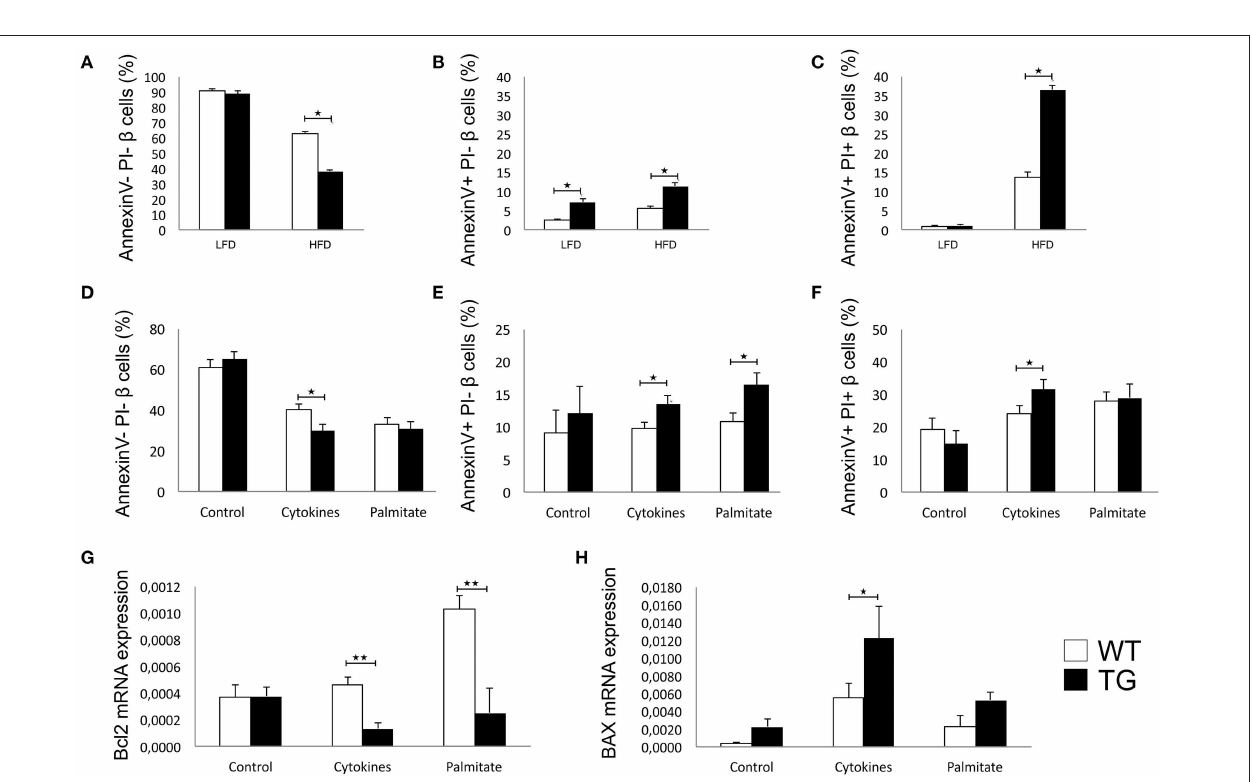
FIGURE 3 | TG mice on HFD compared to WT mice (D) . Percentage of β cells, TLR4 + and galectin 3-positive β cells in islets. Analysis of the islet cells did not show a significant difference in the total number of β cells in islets in the two experimental groups on HFD. However, there was a significantly higher percentage of Glut-2-positive cells expressing TLR4 and galectin 3 in the TG mouse group (E–G) . Percentages of F4/80 + , F4/80 + TLR4 + , and F4/80 + Galectin3 + cells in islets. Representative contour plots for F4/80 + TLR4 + cells in islets. The percentage of F4/80 + macrophages, as well as the percentage of galectin 3-positive and TLR4-positive macrophages, was significantly higher in the islets of TG mice (H–J) . An analysis was performed by light microscope using a 40X magnifying lens. Results are presented as a mean count of positive cells per field or percentage of islet area on 10 non-overlapping fields/section. Data from two experiments with 10–15 mice per group are shown as mean ± SEM; by Mann-Whitney U -test and independent-sample Student’s t -test; * p < 0.05, ** p < 0.01.